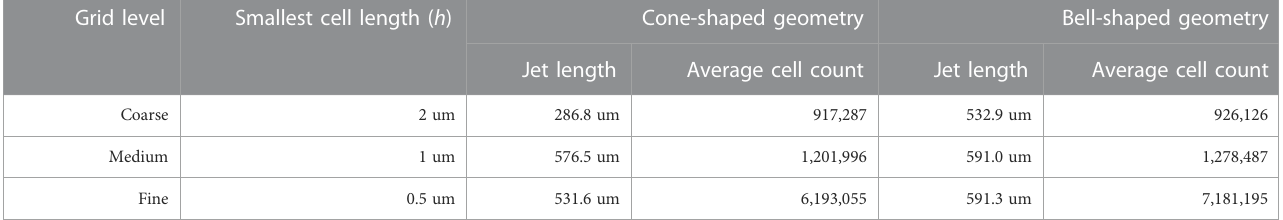
TABLE 1 Mean jet-length values inside the domain with three different AMR grid levels. The value h indicates the fi nest resolution at the interface after AMR. Grid level